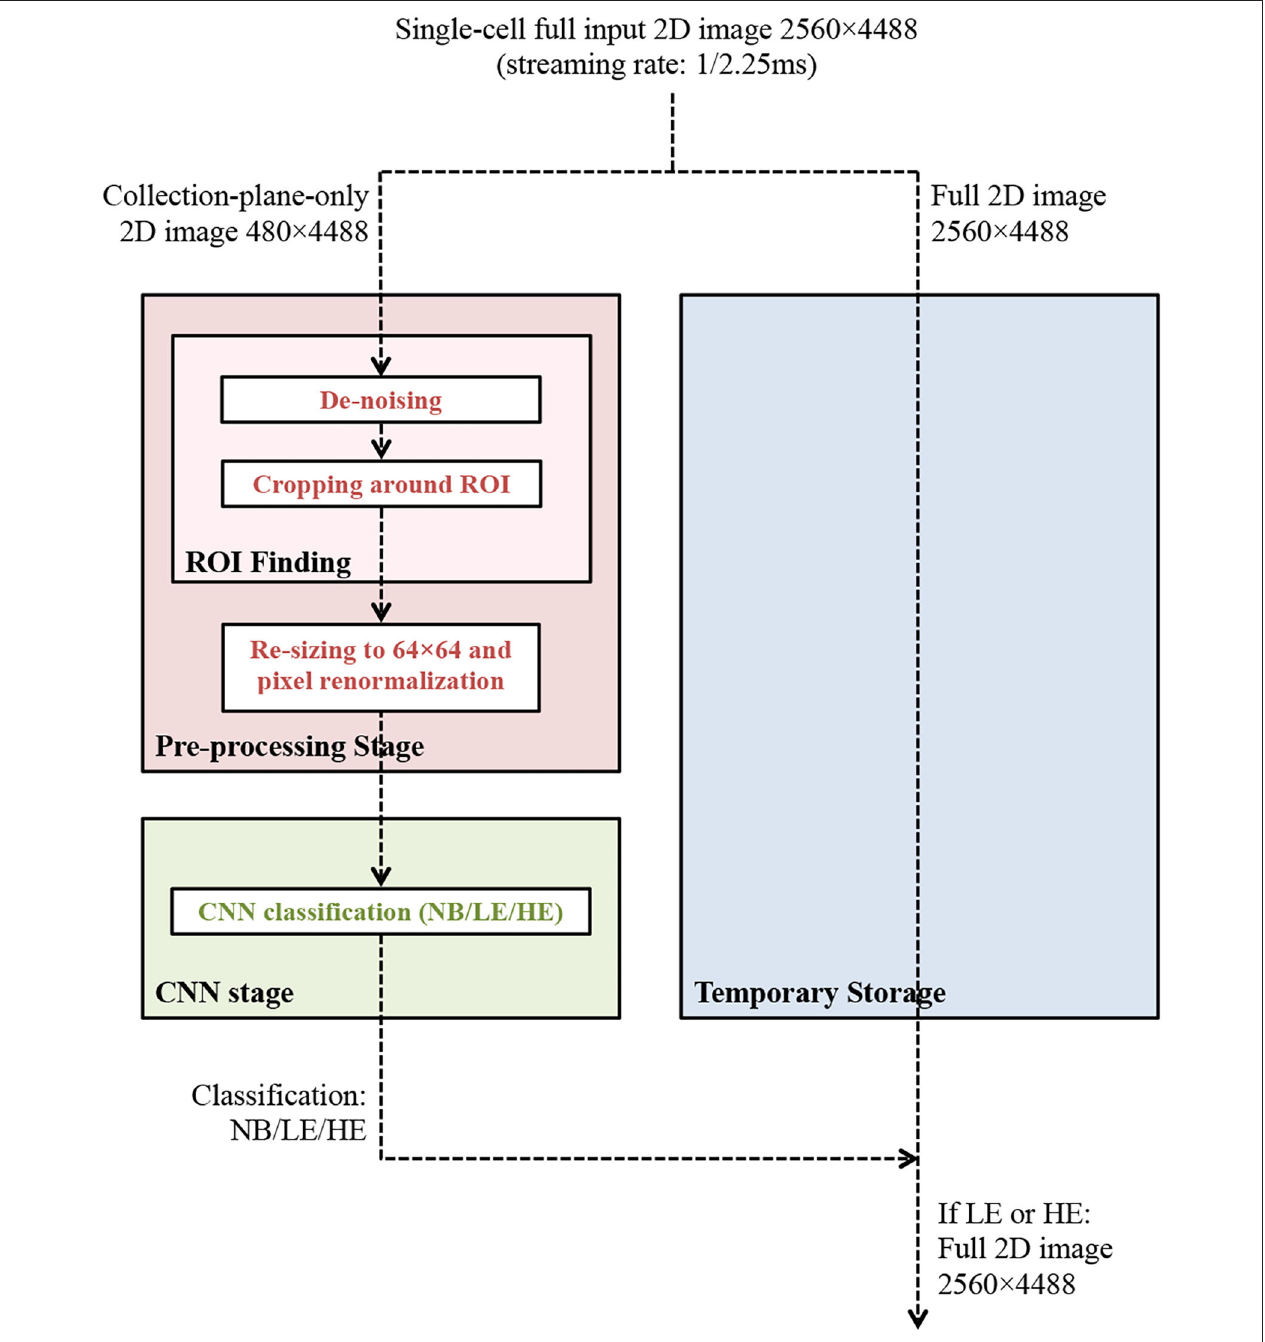
FIGURE 4 | The data processing and data selection scheme under study for potential implementation in the upstream DAQ readout units of the future DUNE FD. The streaming 2D input images contain, > 99.9% of the time, NB data. This overall scheme should select true HE and LE images with > 90% accuracy, and true NB images with > 99.99% accuracy, in order to meet the DUNE FD physics requirements. Additionally, the pre-processing and CNN inference algorithms should meet the computational resources of the DUNE FD upstream DAQ readout units, and the algorithm execution latency should meet the data throughput requirements of the experiment.